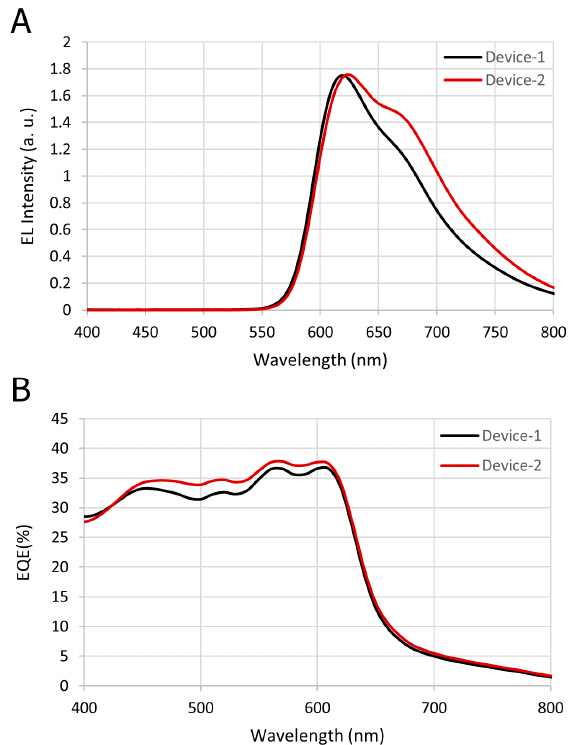
Figure 6. ( A ) The OLED’s electroluminescence spectrum with respect to wavelength (nm). ( B ) The OPD’s external quantum e ffi ciency (EQE) with respect to the wavelength.